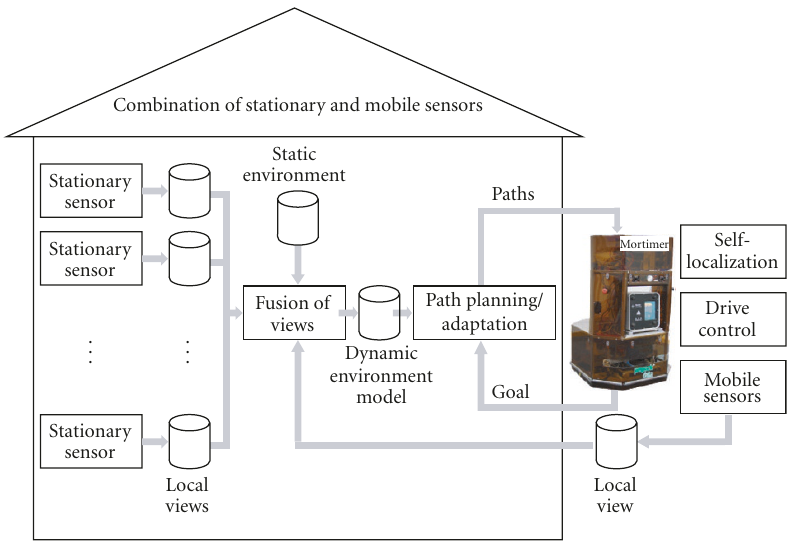
Figure 3: Simplified dataflow